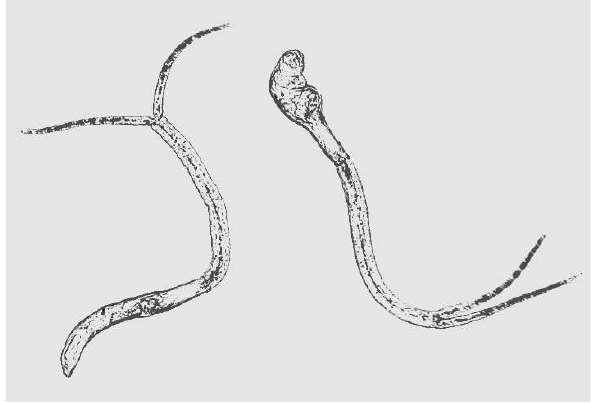
Figure 4. The appearance of Trichobilharzia szidati . A detection place: the lake of Naroch (the Minsk region, the Mjadelsky destrict). Lymnaea stag - nalis is an intermediate